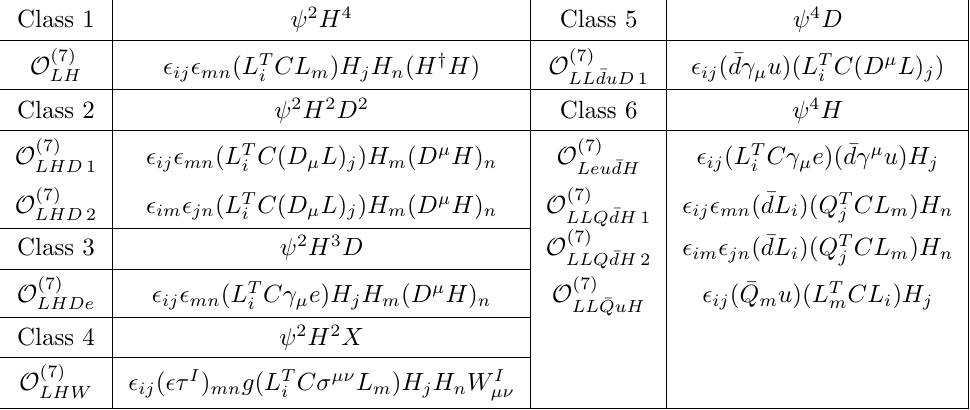
Table 2 . LNV dim-7 operators [87] involving active neutrinos that a(cid:11)ect 0 (cid:23)(cid:12)(cid:12) at tree level.